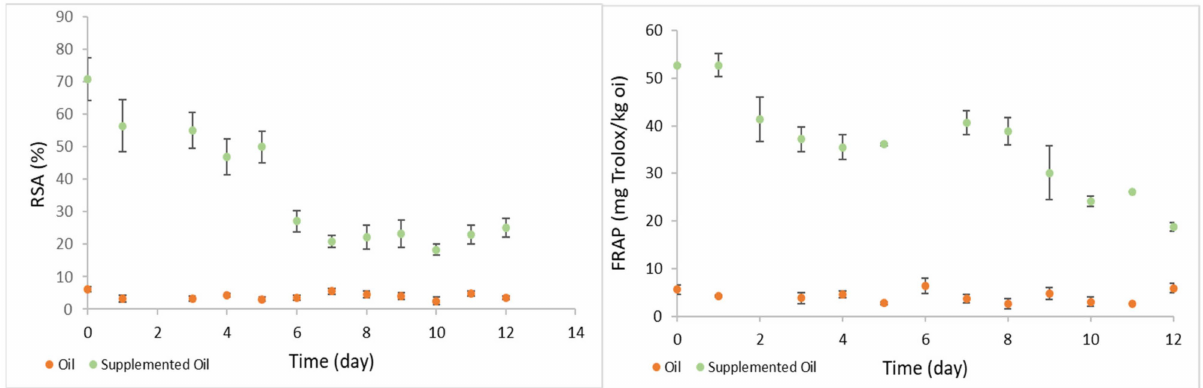
Figure 7. Evolution of the radical scavenging activity (RSA, %) and the antioxidant activity (mg of Trolox equivalent/kg oil), assayed by FRAP method, in non-supplemented and supplemented oil samples, along storage at 60 ◦ C for 12 days under